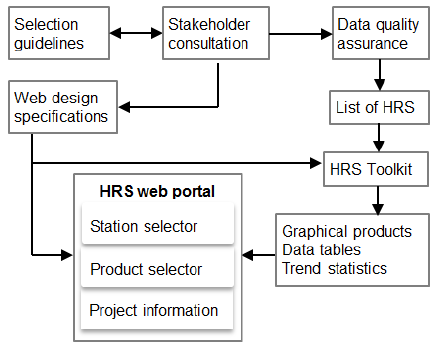
Figure 2. Framework of developing